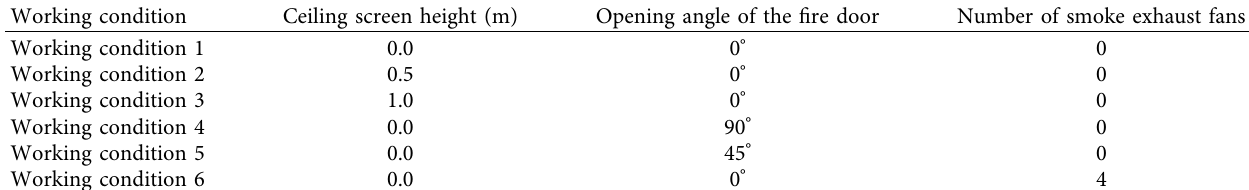
Table 2: Fire scenario settings.